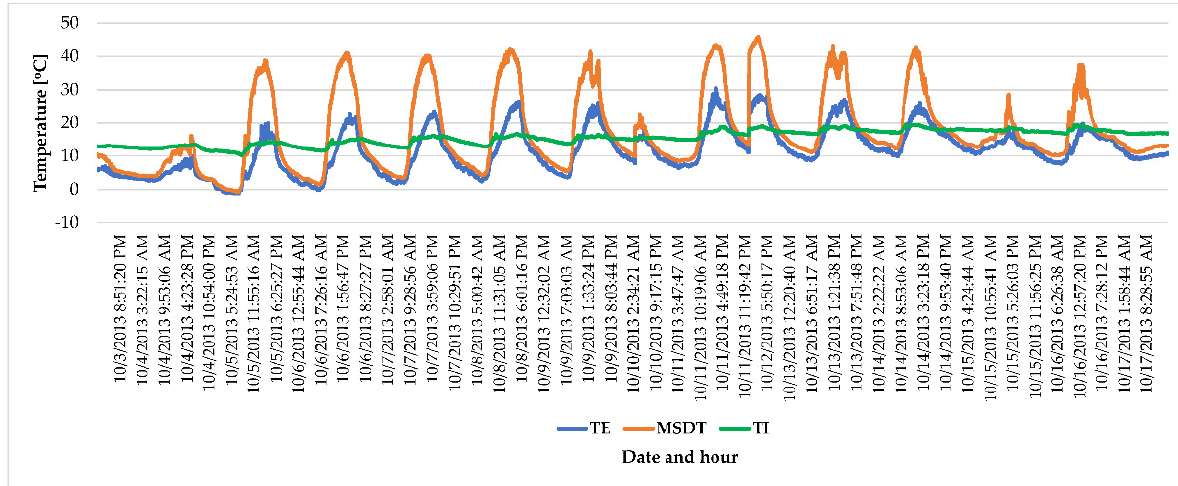
Figure 9. Measurements of the transition season, 3 October–17 October 2013.